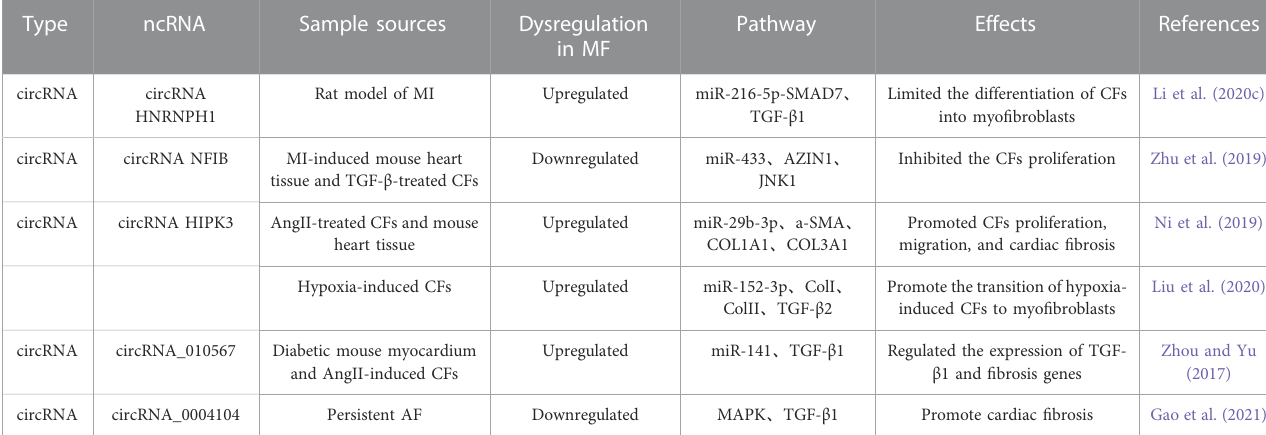
TABLE 3 Mechanism of lncRNA regulating TGF signaling pathway.